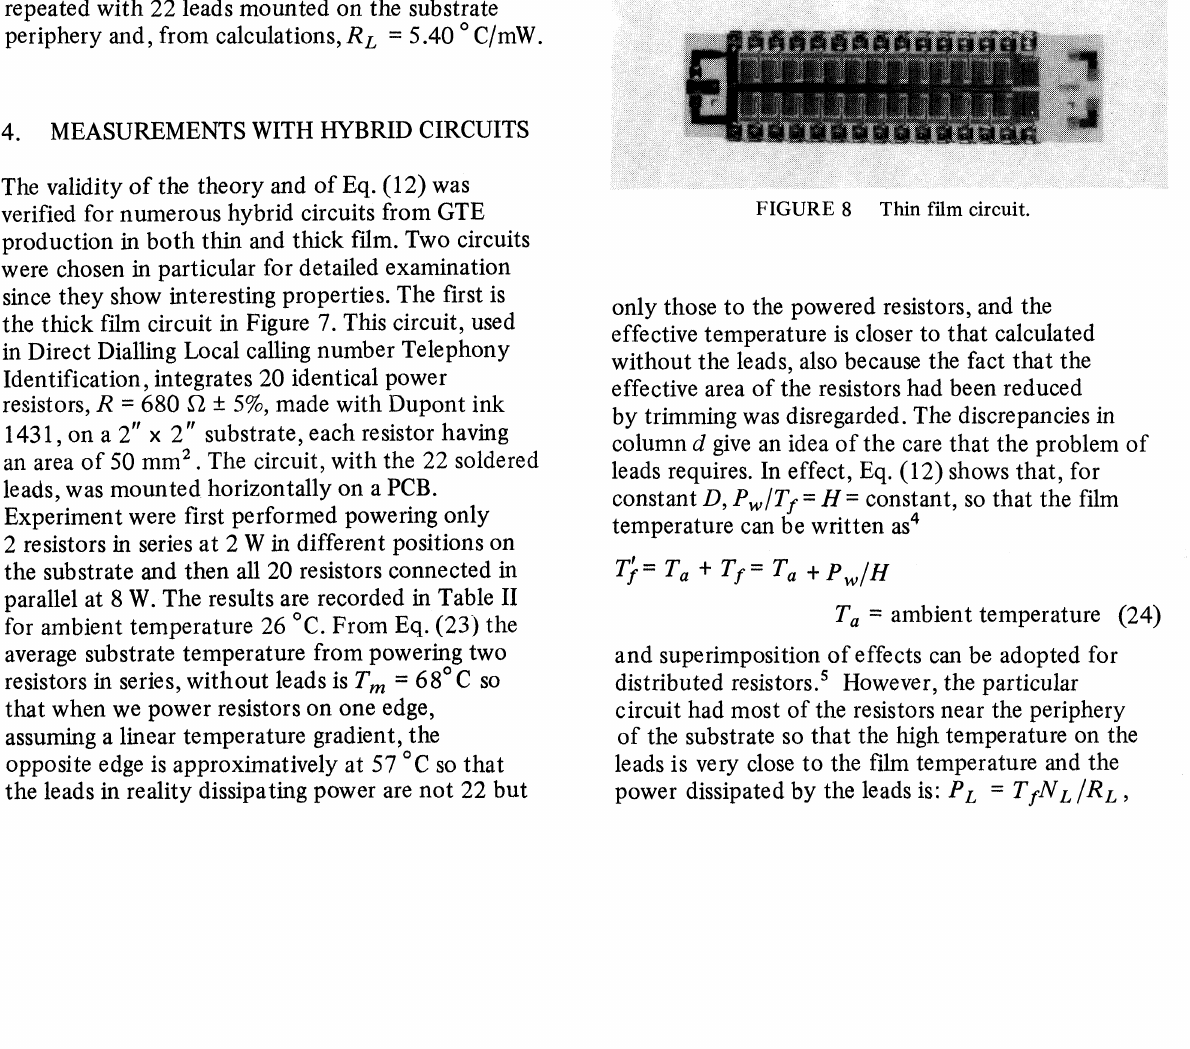
Thick film circuit.